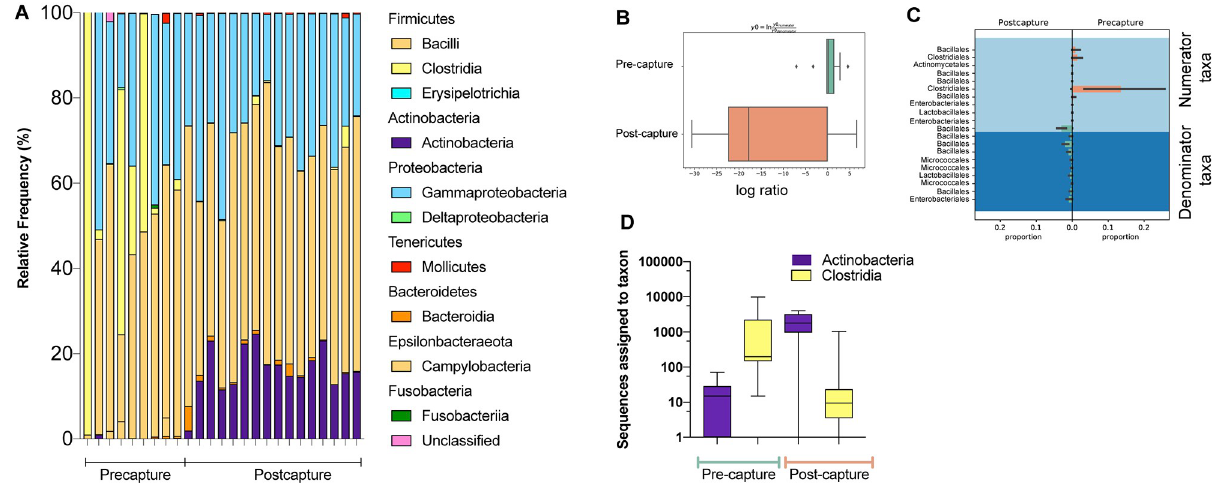
Fig 3. Taxonomical variation in abundance between fecal samples. The relative frequency of reads that mapped to classified features are shown in A at the class level for each bat sample collected pre-capture and post-capture. Feature abundance was clustered in reference to capture status and the log ratio is shown for balance y0 in B . The top 10 taxa at the level of order assigned to numerator or denominator with the largest positive and negative log fold changes are shown in C . The specific bacterial classes identified that were significantly different in ANCOM analysis and their sequence abundance in pre-capture and post-capture datasets ( D